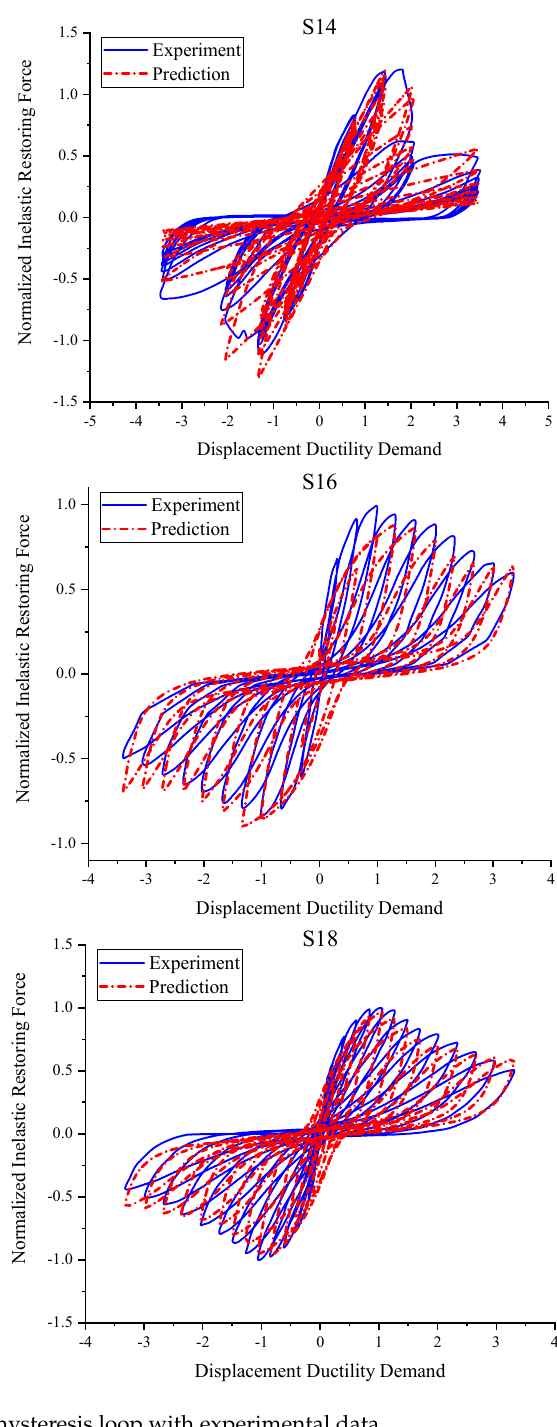
Figure 5. Comparison of predicted hysteresis loop with experimental data. The parameters of the BWBN material constitutive are identified by the deep learning method. Finally, the assigned BWBN material constitutive model is added to the beam column joint element. The Eom’s cast-in-situ cross joint experiment was selected as the experimental data [72]. Cyclic loading is carried out by the displacement loading method. The geometric dimensions and reinforcement of joints can be found in [72,73]. Joint2d-1 joint is used as the joint numerical model, and the hysteretic material in the core area of the joint is simulated by the BWBN model. The simulation results of hysteretic loop is shown in Figure 6. It can be seen that the BWBN model can be well used for nonlinear simulation of stiffness, strength and pinching of RC structures.